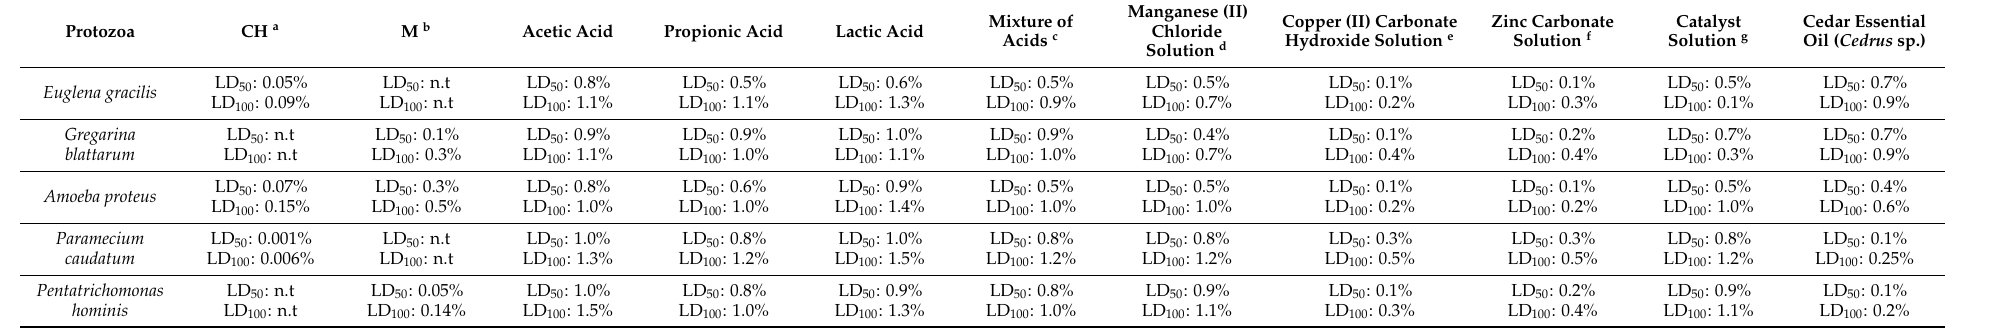
Table 6. LD 50 , LD 100 values of cedar essential oil ( Cedrus sp .) and the components used in the study.